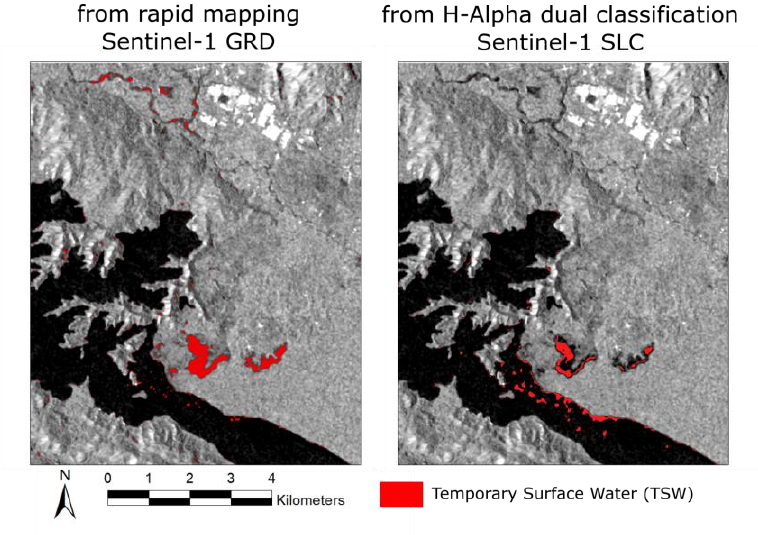
Figure 3. Temporary Surface Water (TSW) results from rapid mapping of Sentinel-1 GRD and from H-Alpha dual classification of Sentinel-1